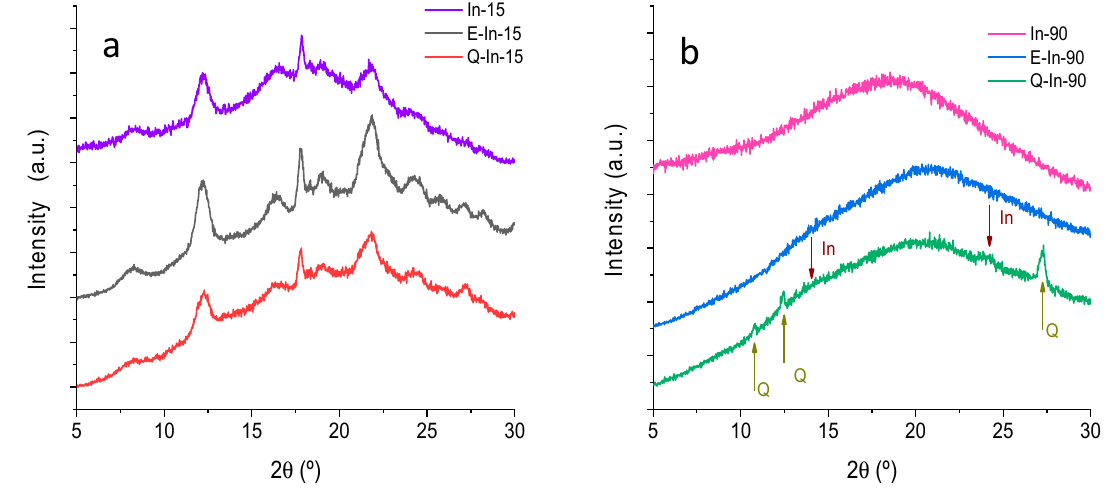
Figure 1. X-ray diffractograms for In-15, E-In-15, and Q-In-15 ( a ), and for In-90, E-In-90, and Q-In-90 ( b ).